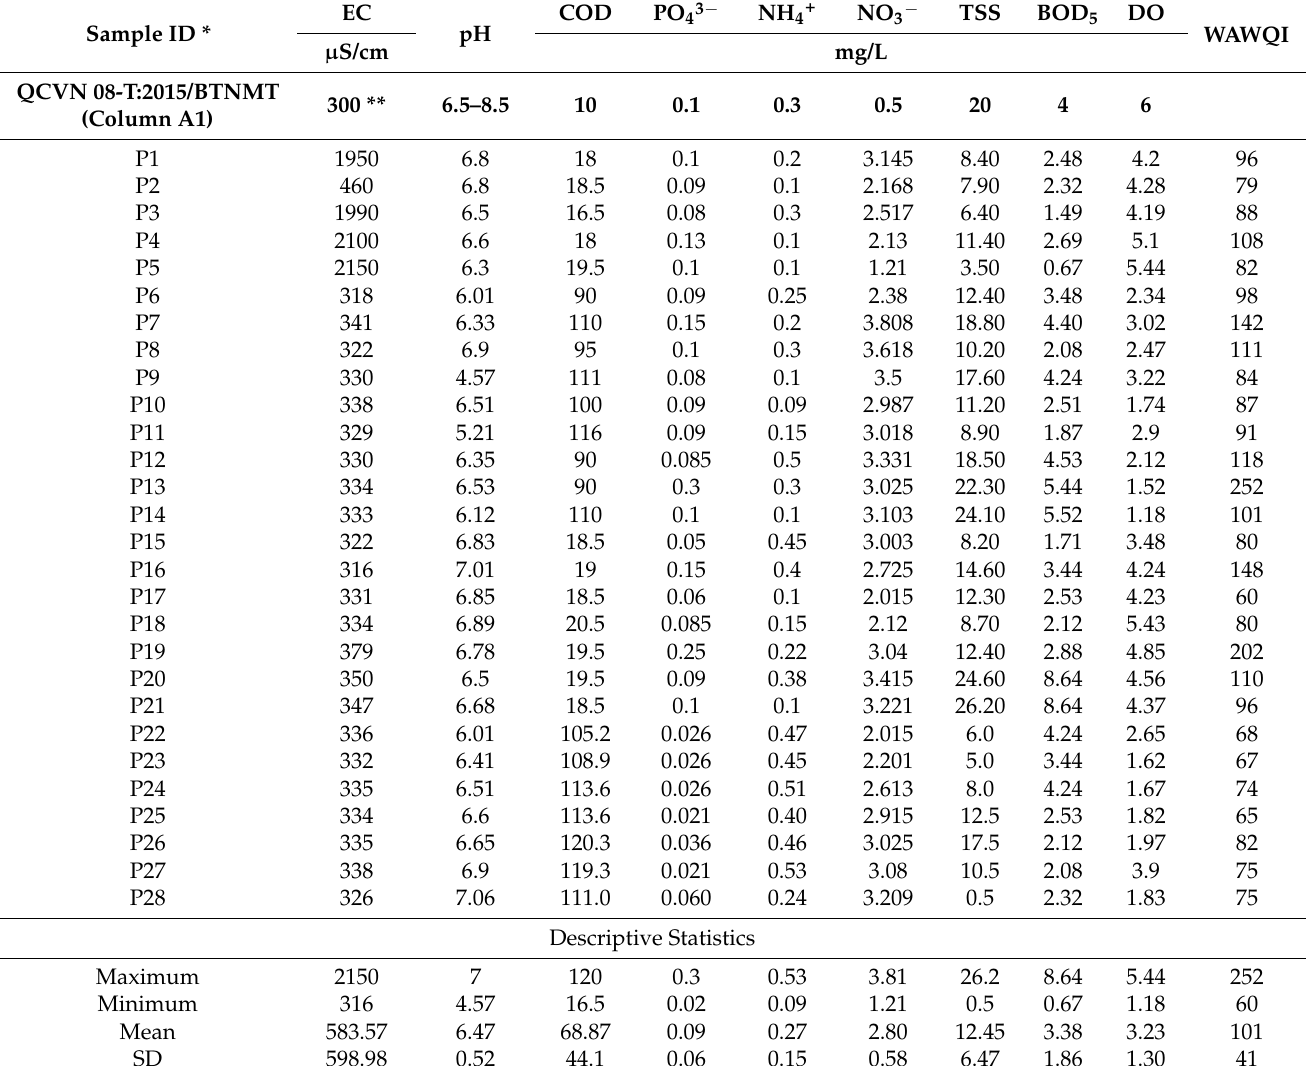
Table 8. Calculation of WAWQI for data at MPMF in Dry season